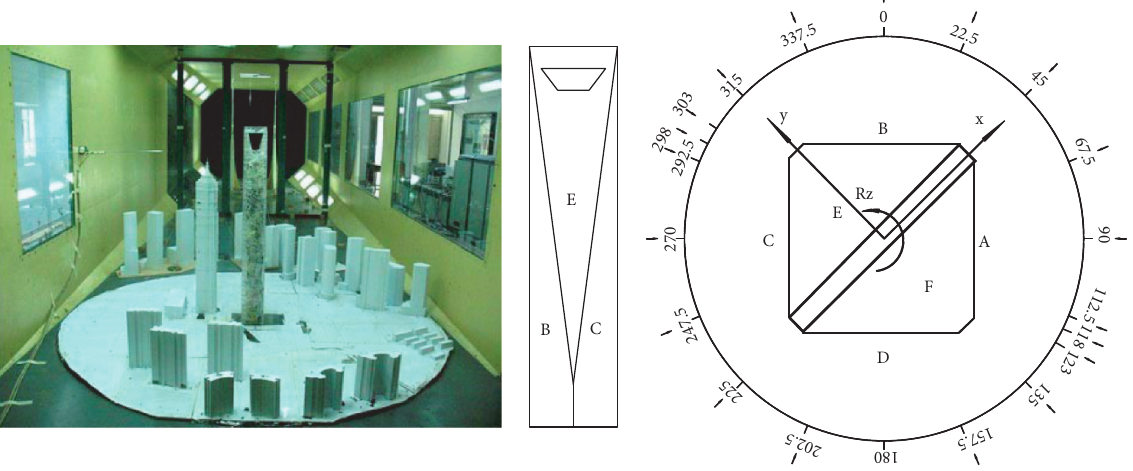
Figure 6: Setup, facade, wind direction, and coordinate axis of the rigid model.